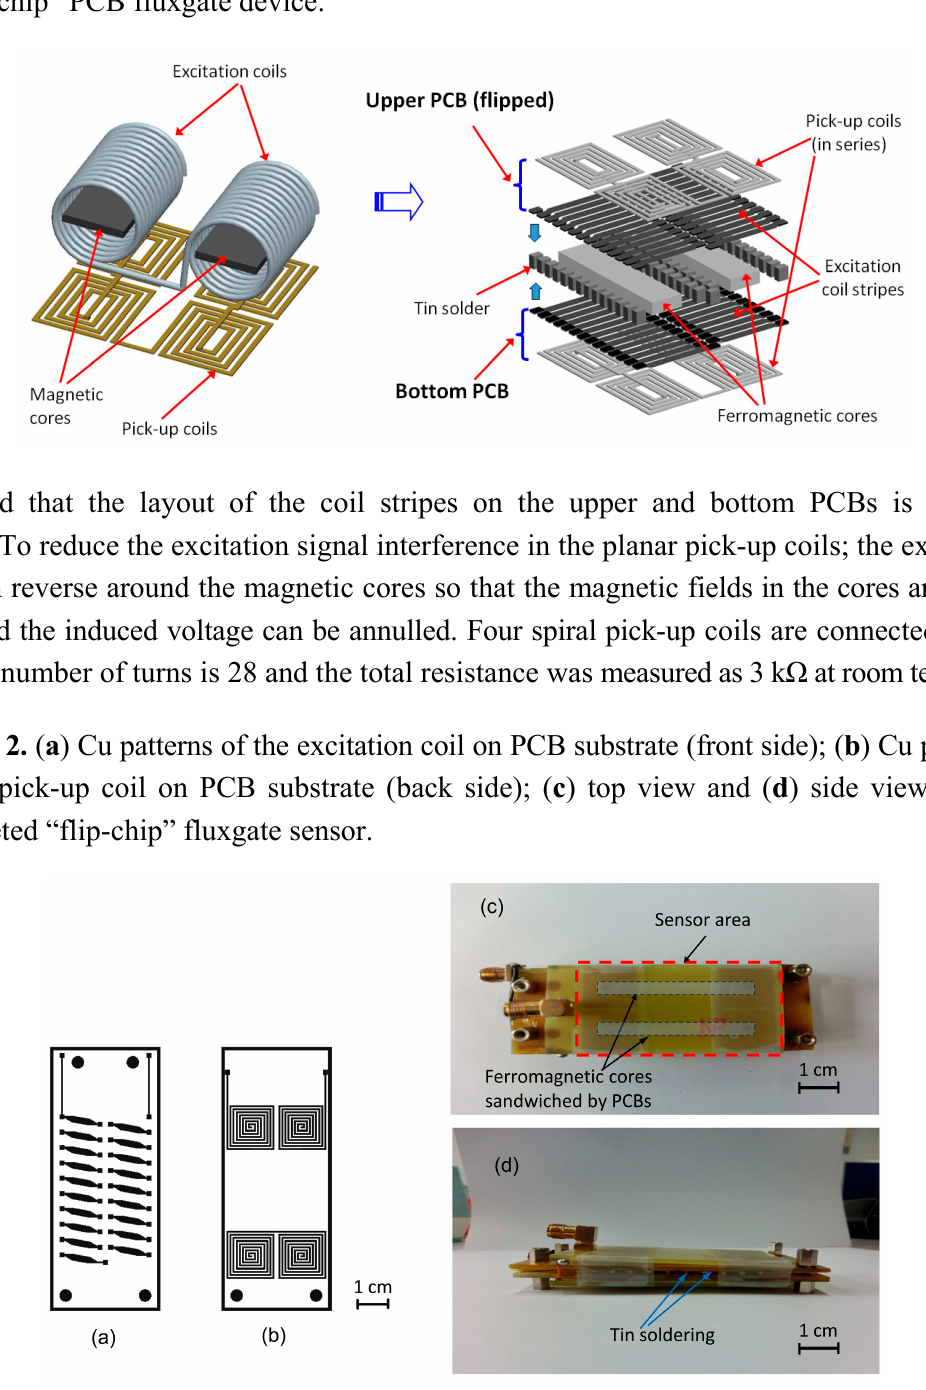
Figure 1. Conceptual schematic of the structure conversion from a wire-wound fluxgate to a “flip chip” PCB fluxgate